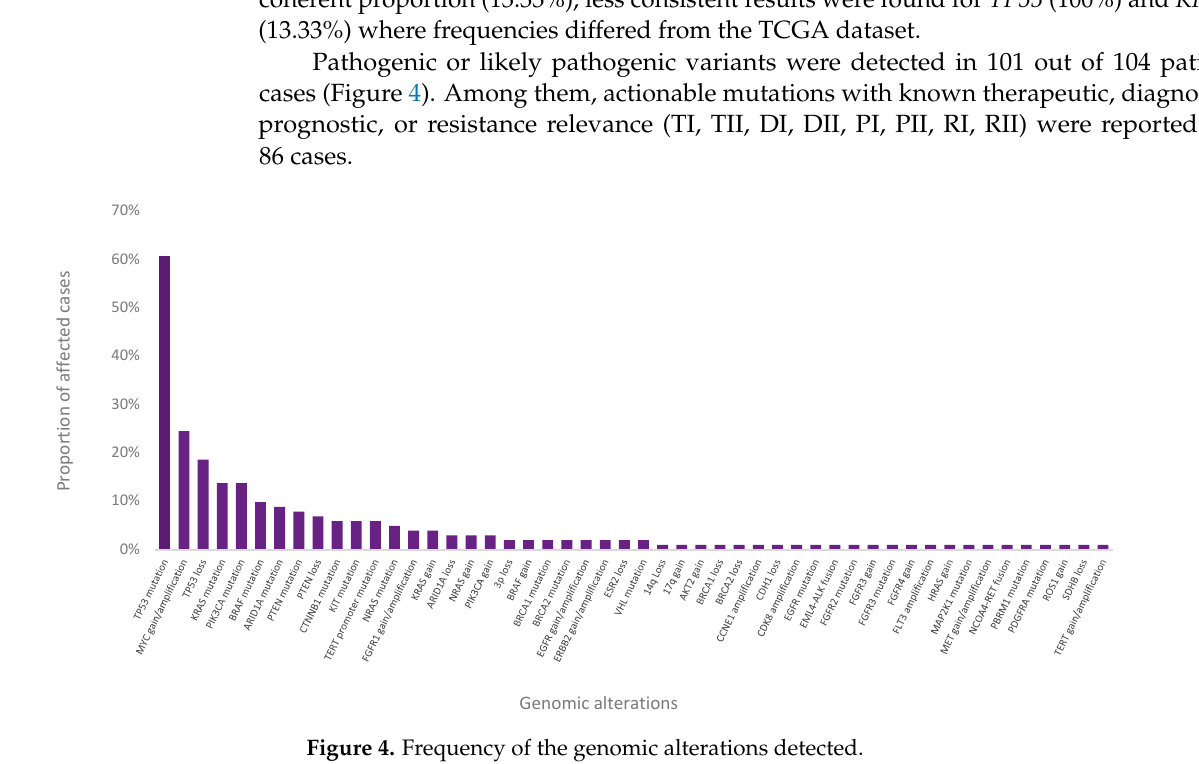
Figure 4. Frequency of the genomic alterations detected.